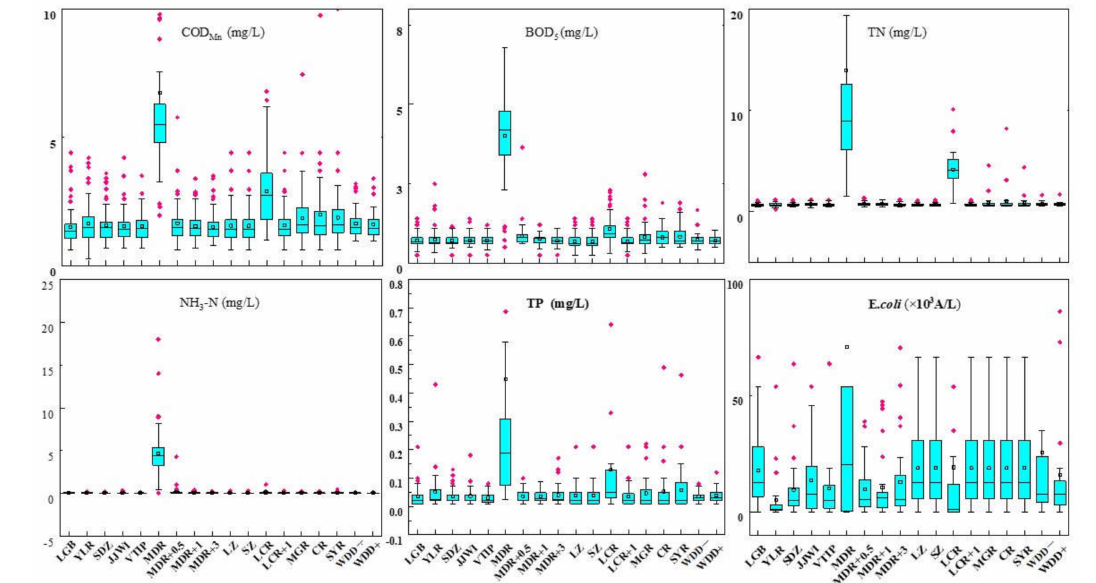
Figure 6. Water quality parameters at each sampling site from 2016 to 2020. Luoguo Bridge, LGB; Yalong River, YLR; Sanduizi, SDZ; Jinjiang Water Intake, JJWI; Vanadium Titanium Industrial Park, VTIP; Madian River, MDR; 0.5 km downstream of Madian River, MDR + 0.5; 1 km downstream of Madian River, MDR + 1; 3 km downstream of Madian River, MDR + 3; Lazha, LZ; Shizhuang, SZ; Longchuan River, LCR; 1 km downstream of Longchuan River, LCR + 1; Mengguo River, MGR; Chen River, CR; Shenyu River, SYR; upriver from the Wudongde Dam, WDD-; downstream of the Wudongde Dam, WDD